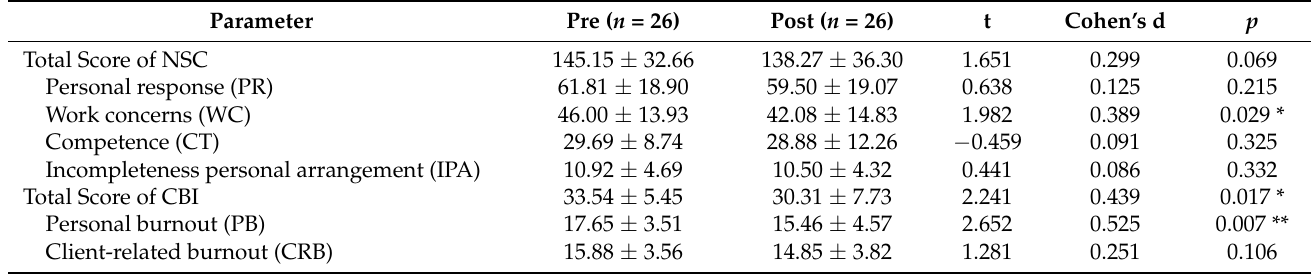
Table 4. Pre-post subjective cognition of paired t-test results for all participants.